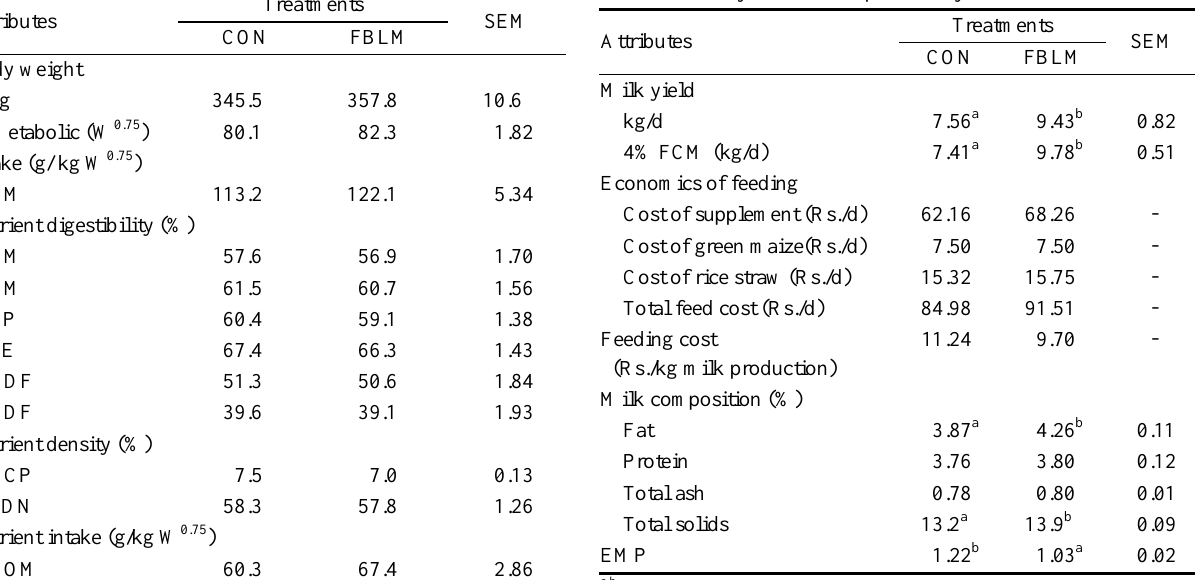
Table 2. Feed Intake, nutrient digestibility and plane of nutrition of crossbred cows without or with CT supplementation Table 3. Effect of CT supplementation through F. bengalensis leaves on milk yield and composition by crossbred